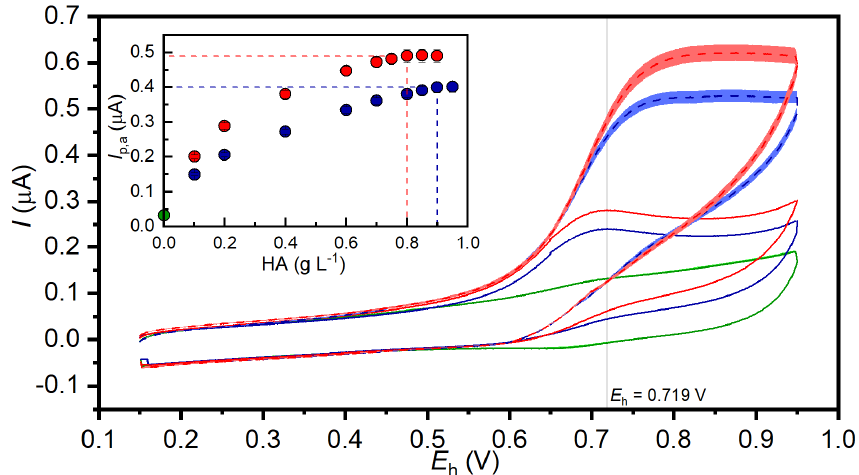
Figure 3. Cyclic voltammograms (CVs) of solutions containing only 3 µM 2,2 ′ -azino-bis(3-ethylbenzothiazoline-sulfonate) (ABTS 2 − , green trace) and ABTS 2 − plus varying amounts of HA ox (0.1 and 0.9 g L − 1 , blue traces) and HA red (0.1 and 0.8 g L − 1 , red traces). Inset : anodic peak currents ( I p,a ) versus HA concentrations. The dashed lines indicate the limit currents ( I lim )and the corresponding limiting concentrations.